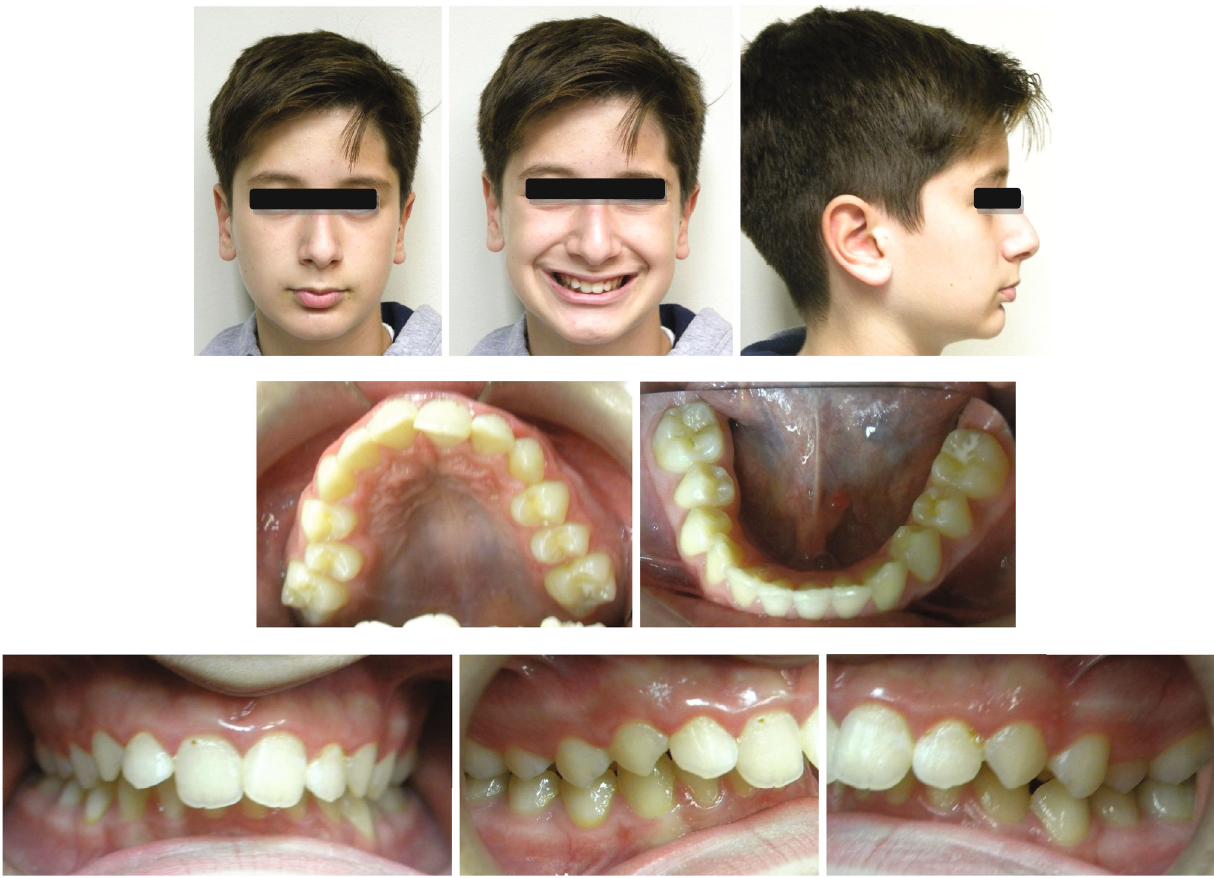
Figure 1: Pretreatment